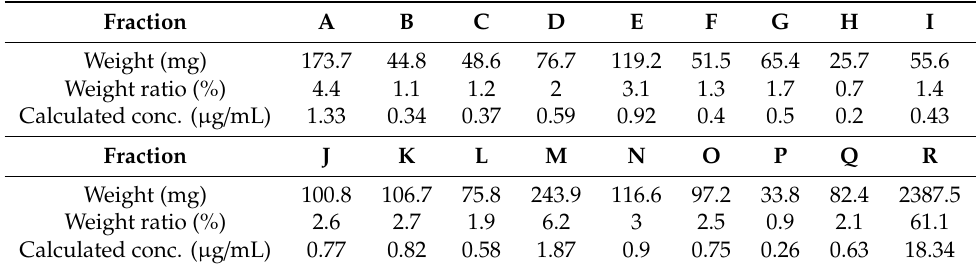
Table 2. Fraction weights and calculated